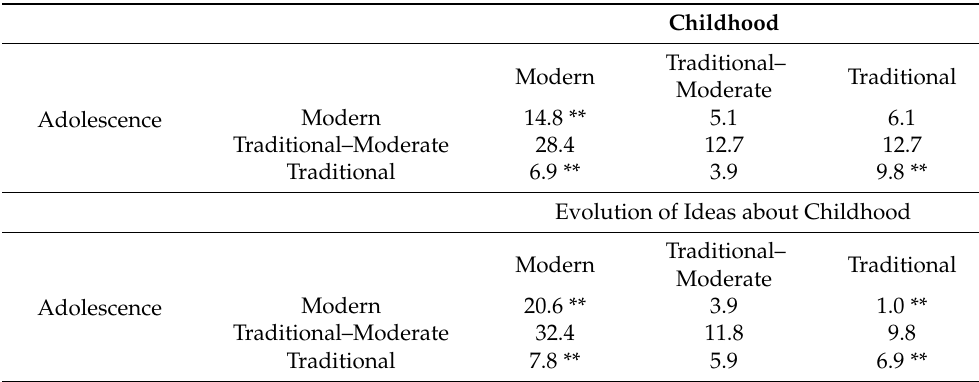
Table 5. Association between parental ideas about childhood and ideas about adolescence in percent- age